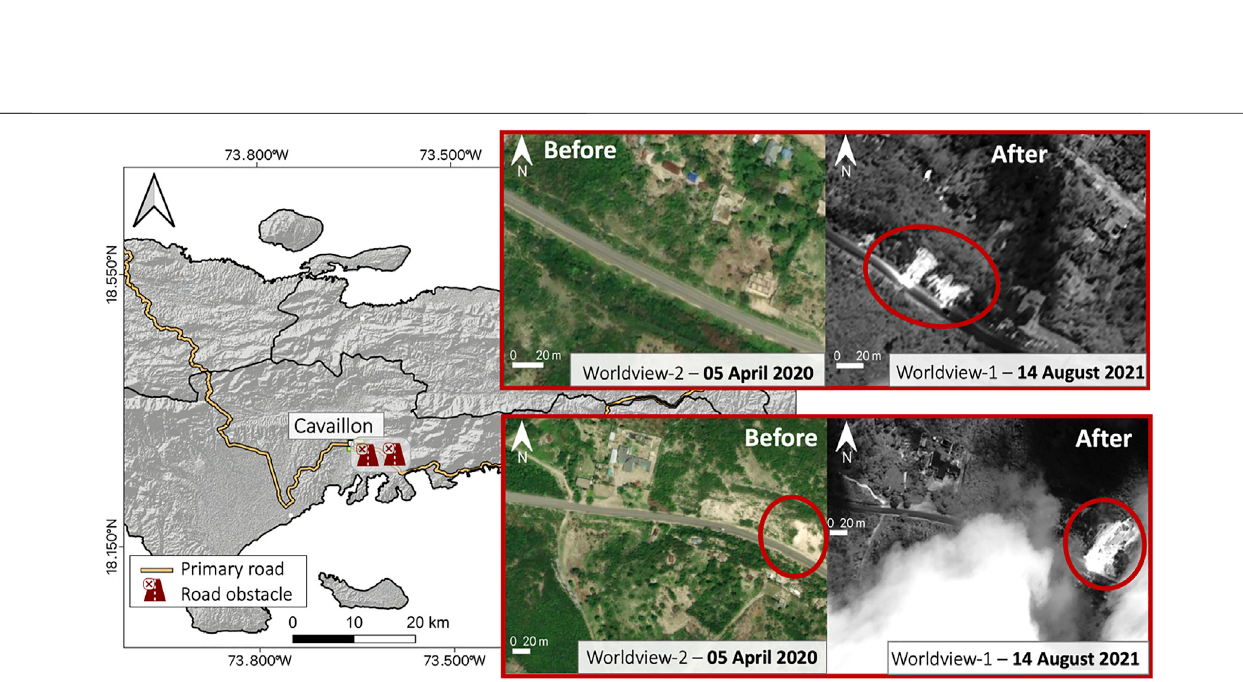
Frontiers in Built Environment |